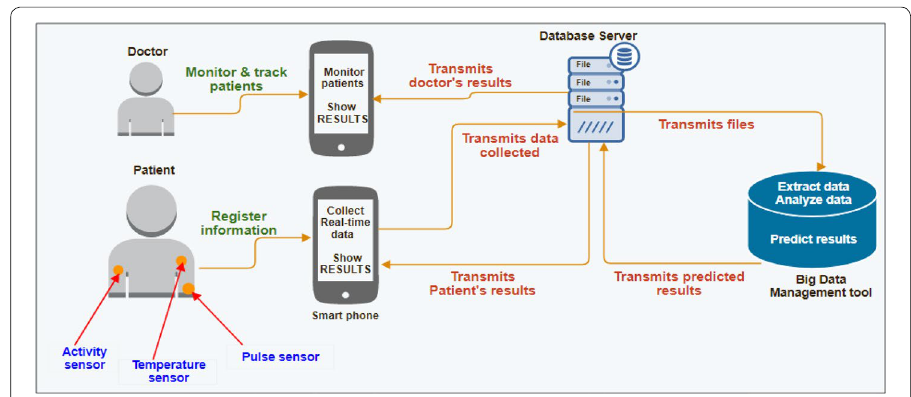
Fig. 1 Prediction system